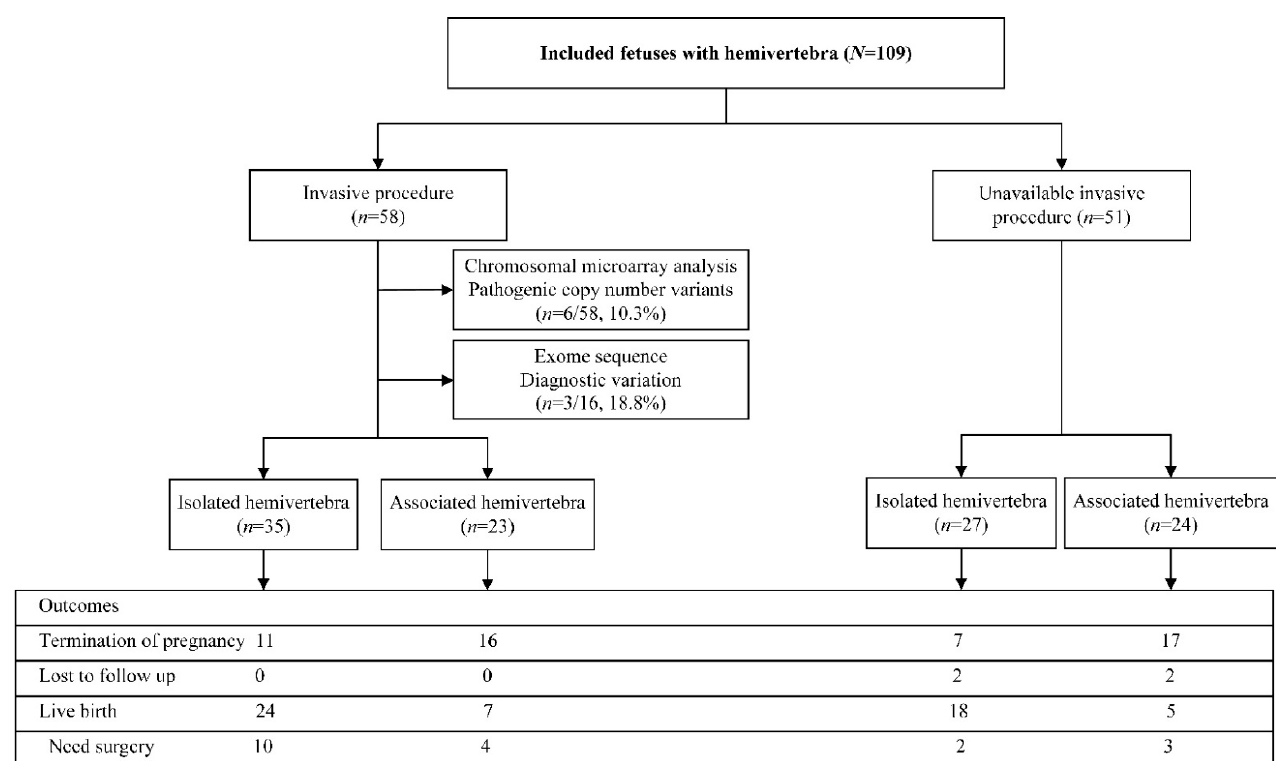
Figure 1. Flowchart of this study. Table 1. Genetic and clinical outcome in fetuses identified sonographically in fetuses with hemi- vertebra.